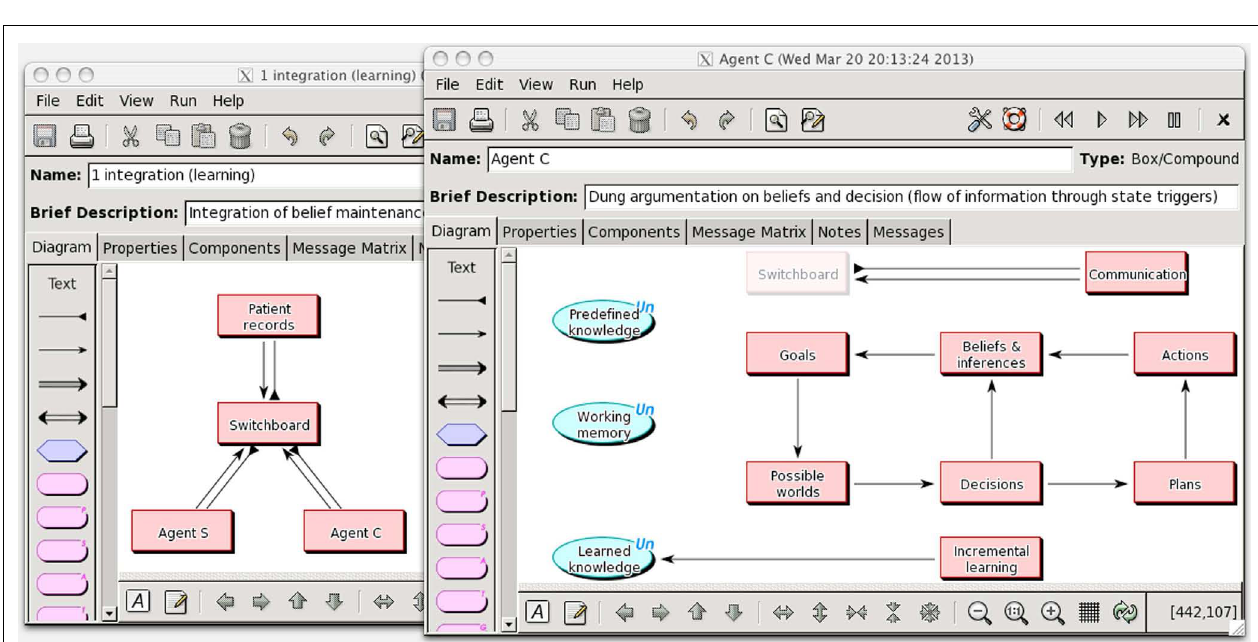
FIGURE 7 | Multi-agent network for cooperative decision-making (left), and information processing architecture for an autonomous agent (right).